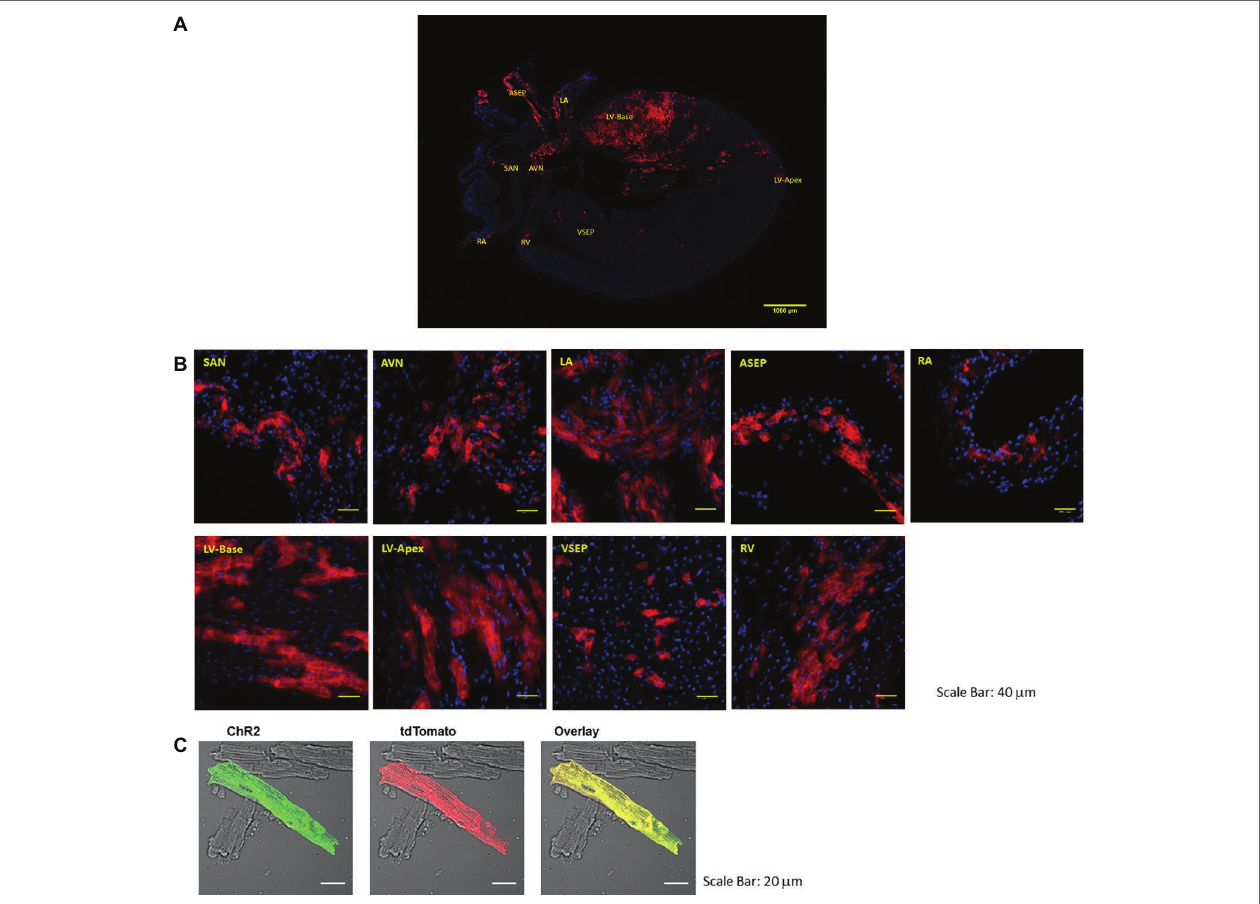
FIGURE 1 | Representative images of the coronal section and selected regions from the section of an adult ChR2/tdTomato mouse heart showing fluorescence and morphology of the ChR2/tdTomato positive cells. (A) A representative coronal section from an adult ChR2/tdTomato mouse heart; (B) inserts of zoom-in views showing tdTomato fluorescence in different regions of the heart; the labeling of the inserts indicates the corresponding locations as marked in (A) . SAN, sinoatrial node; AVN, atrioventricular node; LA, left atrium; RA, right atrium; LV, left ventricle; RV, right ventricle; ASEP, atrial septum; VSEP, ventricular septum. (C) Immunostaining of ChR2 with anti-ChR2 antibody; tdTomato fluorescence in isolated LV cardiomyocytes; overlay showing co-localization of ChR2 and tdTomato [Adapted with permission from Wang et al. (2017) and Ni et al.